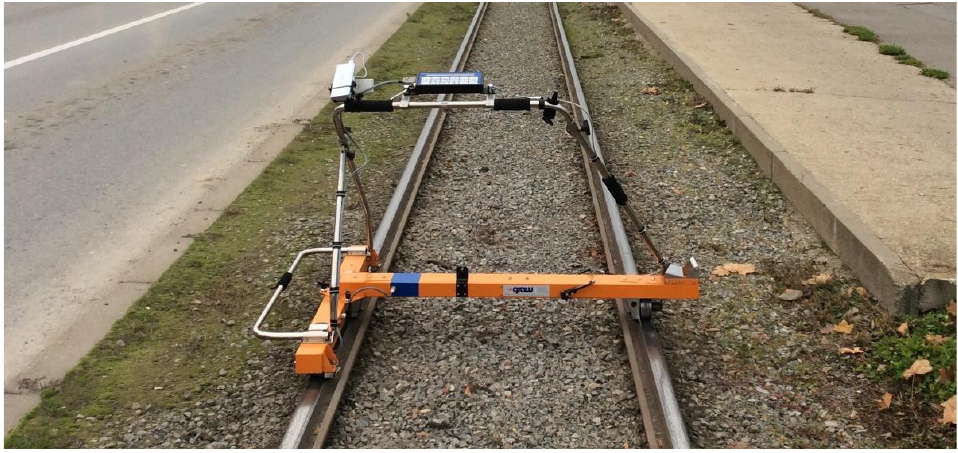
Figure 3. TET-1000